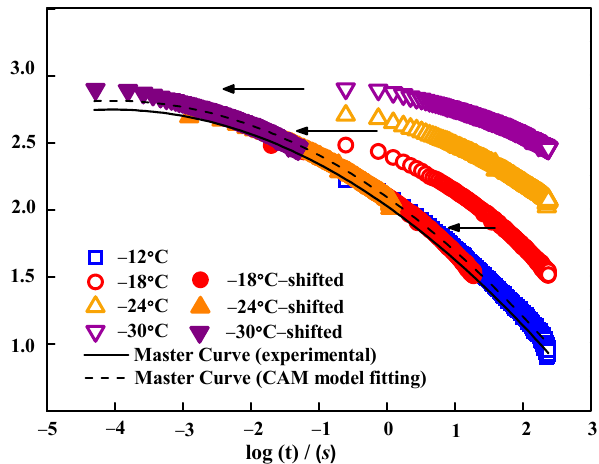
Figure 6. The 𝐸(𝑡) movement process for L3-RAB.